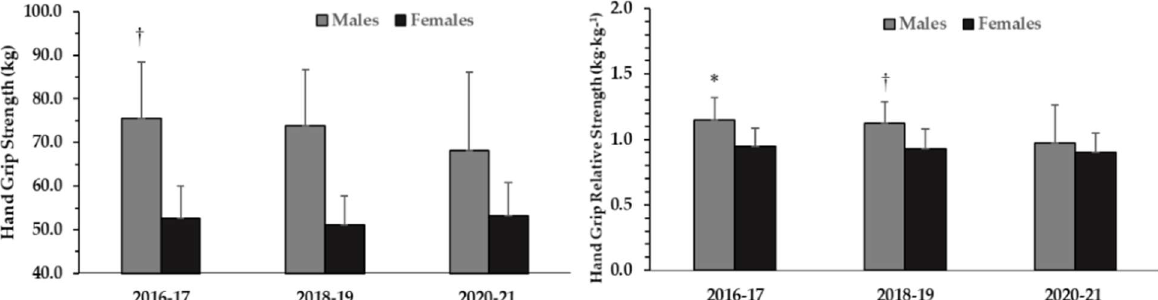
Figure 2. Hand-grip Strength in absolute (left panel) and relative hand-grip strength (right panel) at different school years in males and females presented as means ± SD. *: p < 0.01 from 2020–2021, †: p < 0.05 from 2020–2021.